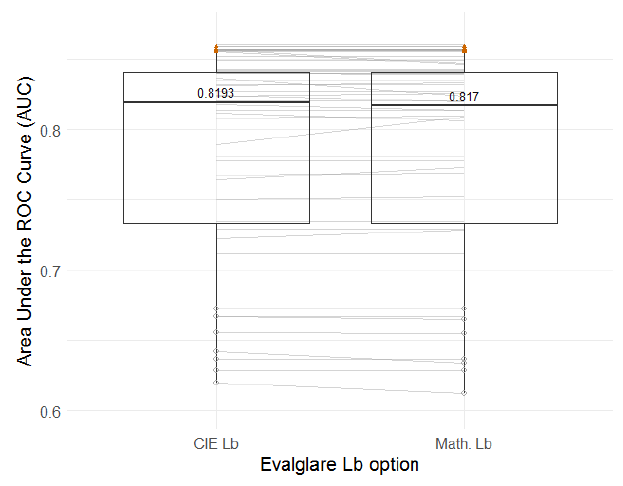
Figure 14. Boxplots of AUC for the two background luminance definitions (field study).